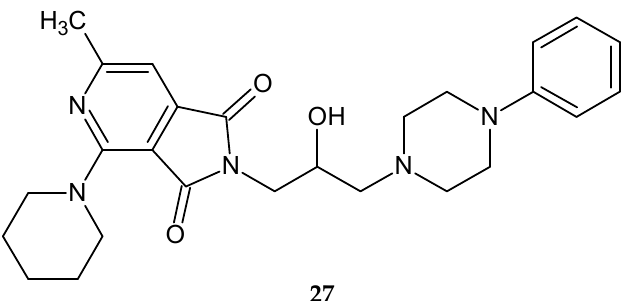
Figure 22. 2 ‐ [2 ‐ hydroxy ‐ 3 ‐ (4 ‐ phenyl ‐ 1 ‐ piperazinyl)propyl] ‐ 4 ‐ piperidino ‐ 6 ‐ methyl ‐ 1 H ‐ pyrrolo[3,4 ‐ c ]pyridine ‐ 1,3(2 H ) ‐ dione 27 .